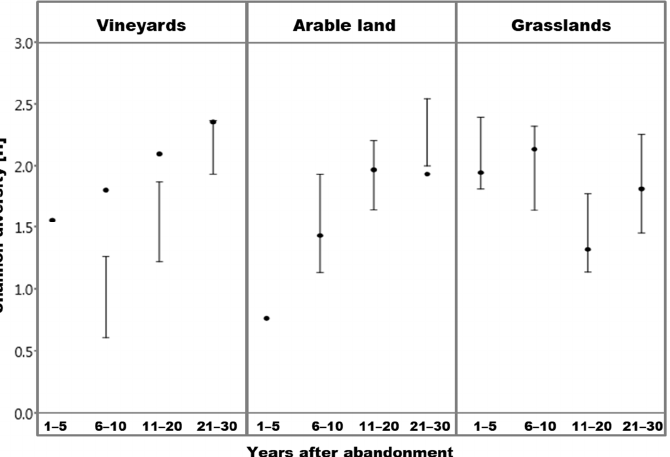
Figure 4. Shannon diversity values of forest steppe species in different age groups of abandoned lands (V—vineyards, A—arable land, G—grasslands).